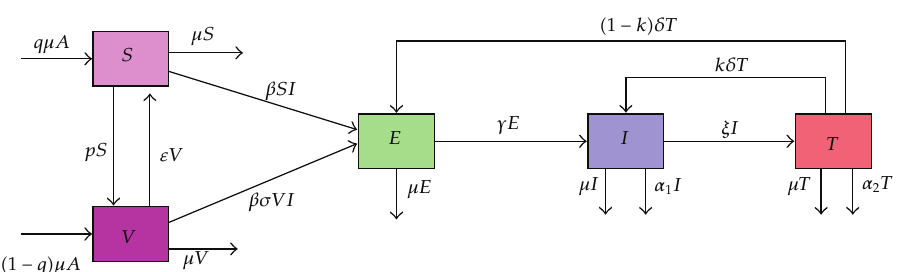
Figure 1: The transfer diagram for the model (cid:2) 2.1 (cid:3)